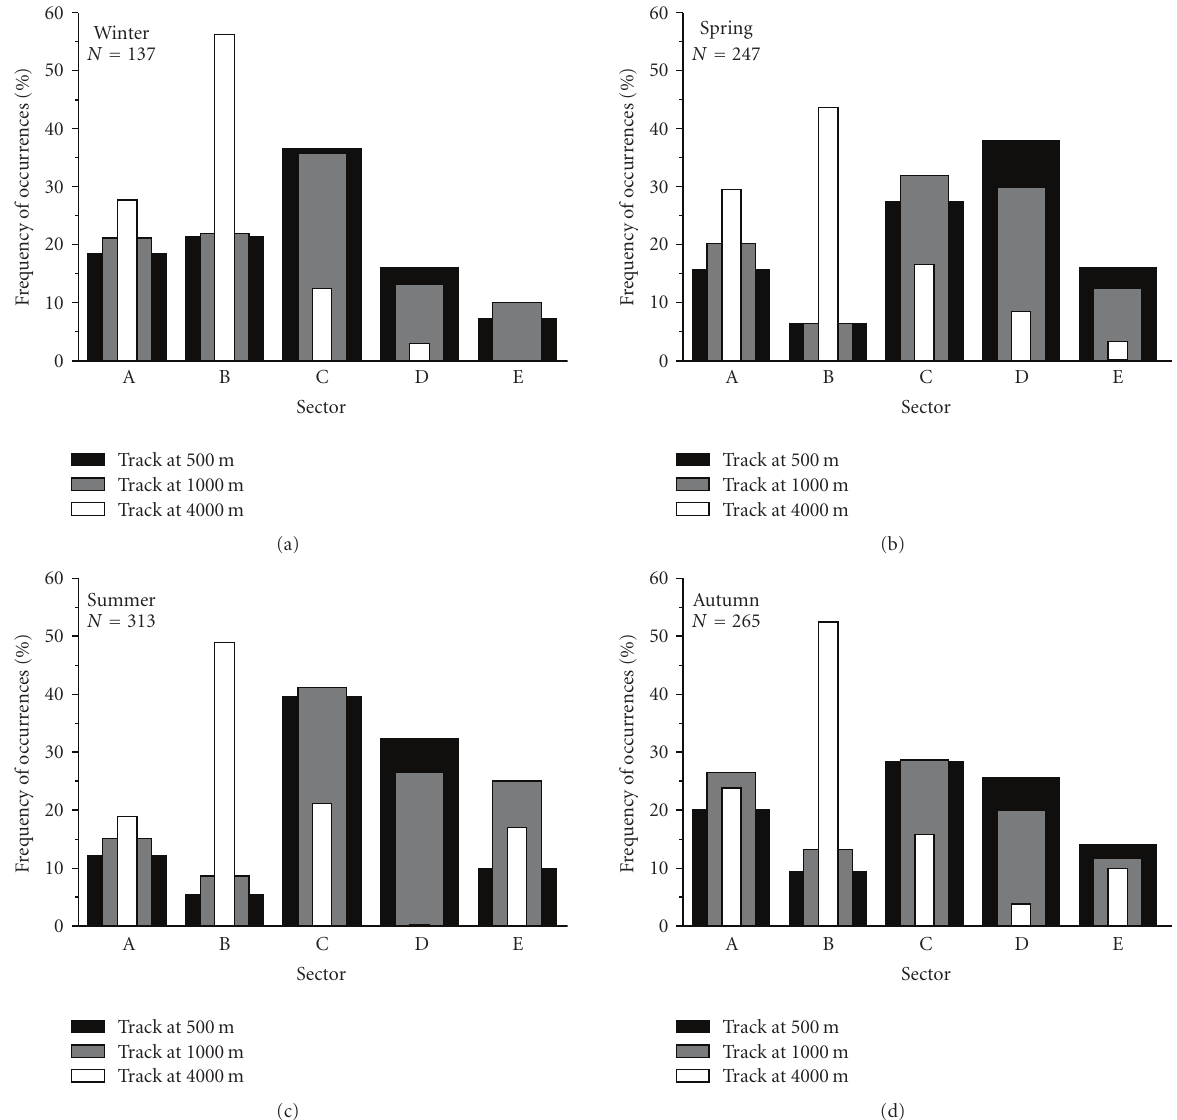
Figure 2: Seasonal frequency (%) distribution of the air-mass trajectories at three atmospheric levels over GAA for the whole dataset. The number of data, N, in each season is also